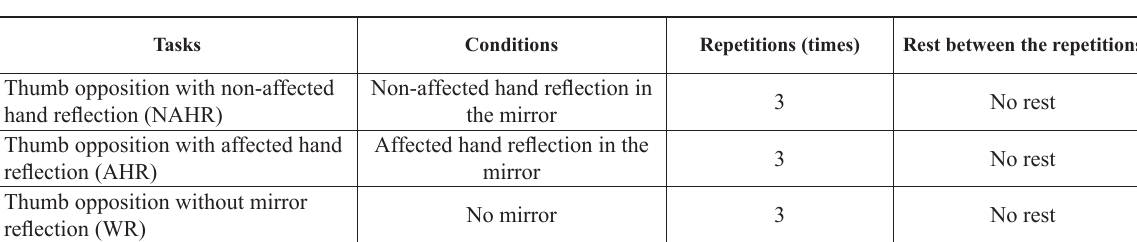
Table. Tasks performed by subjects Tasks